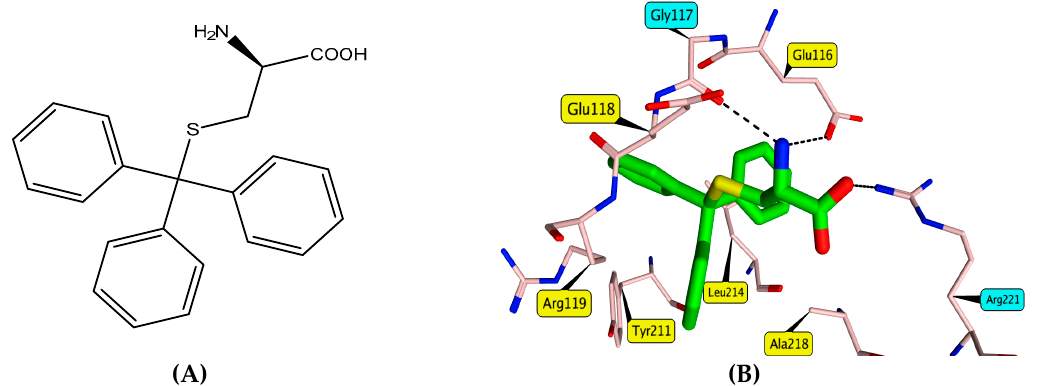
Figure 1. ( A ) S -trityl- l -cysteine (STLC) structure. ( B ) Binding interactions of STLC (green, PDB